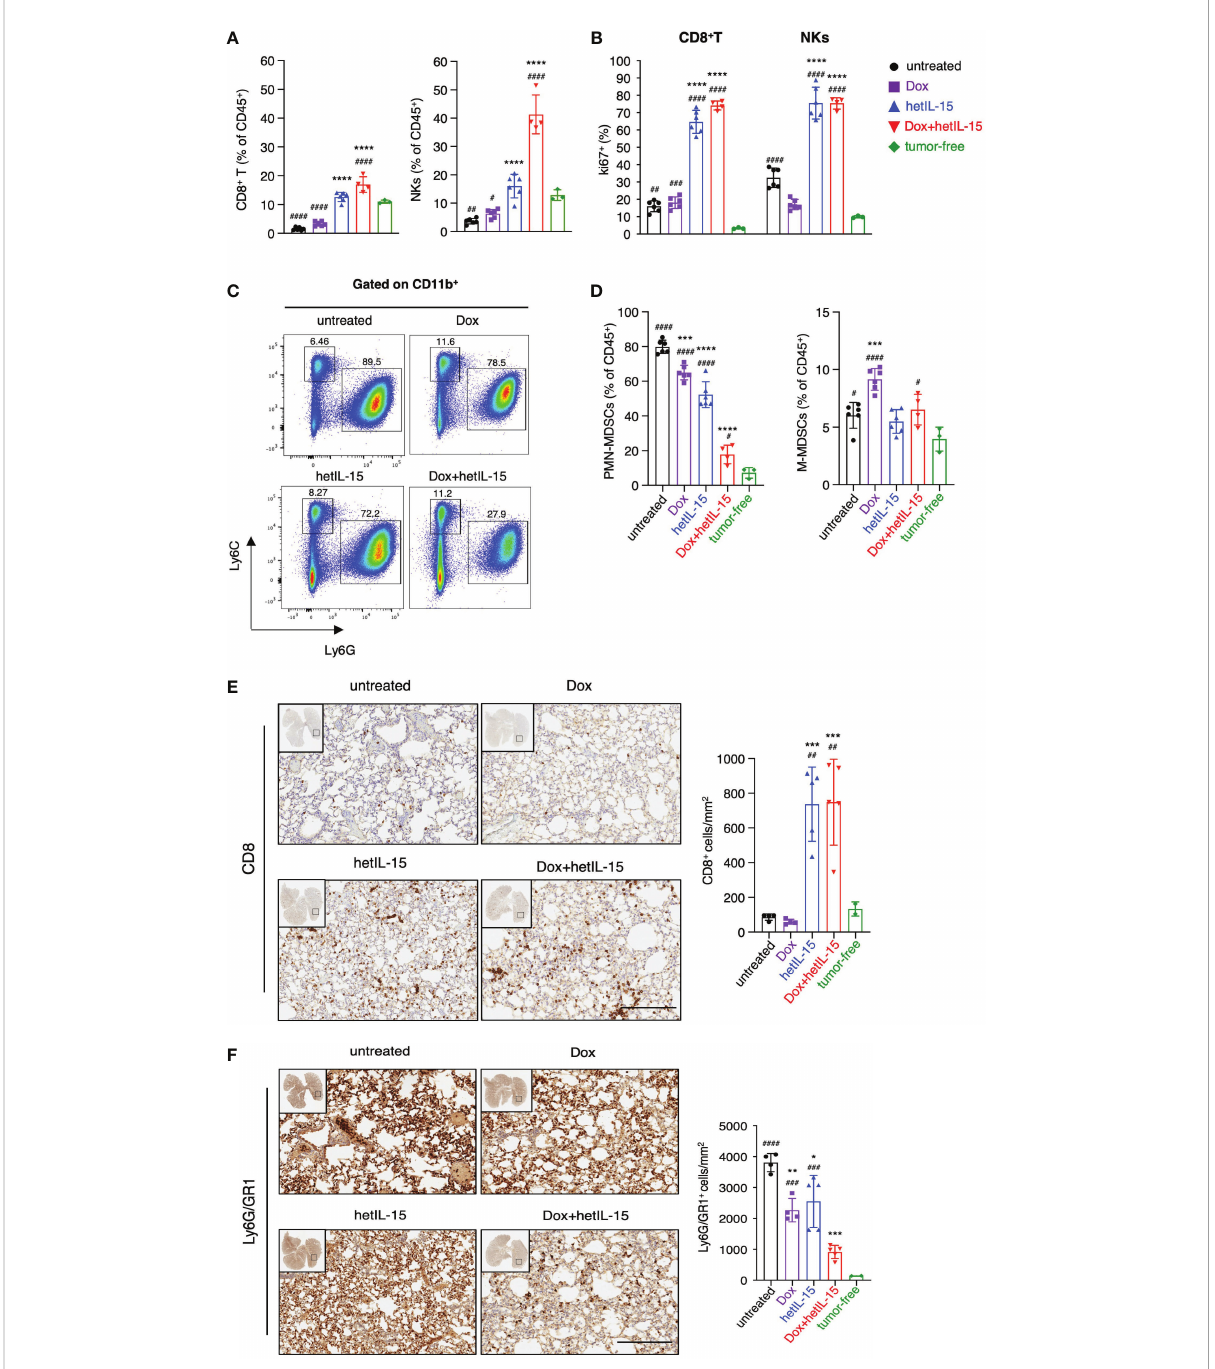
FIGURE 3 hetIL-15 synergizes with doxorubicin to increase CD8 + T and NK cells and to reduce PMN-MDSCs in lungs. Mice were treated following the scheme shown in Figure 1A and the tissues were harvested on day 16. (A) Frequencies and (B) Ki67 expression of CD8 + T and NK cells in the lungs of each group. Data are representative of two independent experiments and bars show the mean ± SD for each group (n= 4-6). (C) Dot plots from a representative animal from each group showing the percentages of PMN-MDSCs and M-MDSCs in lungs gated in CD11b + . (D) PMN-MDSCs and M- MDSCs frequencies in the lungs of each group expressed as percentage of CD45 + cells. Data are representative of two independent experiments and bars show the mean ± SD for each group (n= 4-6). (E, F) Representative IHC images of lung slides stained with anti-CD8 (E) and anti-Ly6G/GR1 (F) for each group. The bar graphs show the absolute numbers of CD8 + cells/mm 2 ( E , right panel) and Ly6G/GR1 + cells/mm 2 ( F , right panel) of the whole lung area in each group. Scale bar, 200 m m. Results were obtained from one experiment; bars show the mean ± SD for each group (n=4-5). Data obtained from lungs of tumor-free mice are also included [n=3 in (A – D) and n=2 in (E, F) ]. Statistical analysis was done by one-way ANOVA and Tukey ’ s or Dunette ’ s multiple comparisons test. Asterisks show the signi fi cance of difference from the untreated group and hashtags from the tumor-free group, *or # p < 0.05, ** or ## p < 0.01, *** or ### p < 0.001, **** or #### p < 0.0001. SD, standard